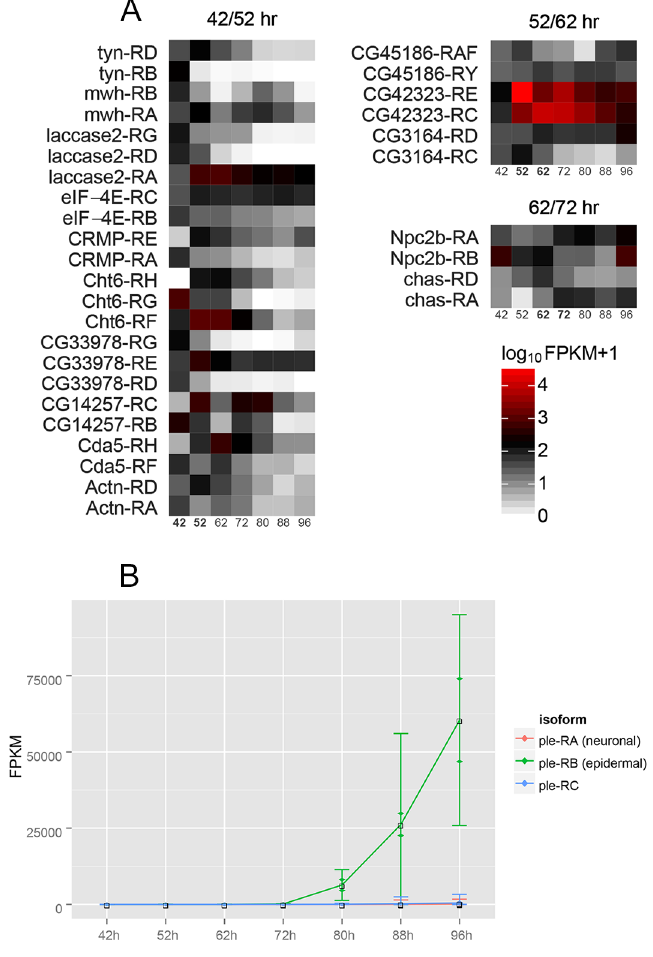
Fig 6. Isoform switching between neighboring time points. A. A heat map is shown for selected genes where we detected putative switching between isoforms. Several of these genes are known/likely to have a role in cuticle formation and or wing development. Among the most interesting were the isoform shifts for Cht6 (which encodes a chitinase), Cda5 (which encodes a chitin deacetylase), laccase (which encodes an oxidase with a role in cuticle formation [40, 57, 58]) and mwh (which regulates wing hair morphogenesis [55, 56]). B. The time course for the expression of the pale isoforms is shown. Note how the 96 hr peak of expression is restricted to the epidermal